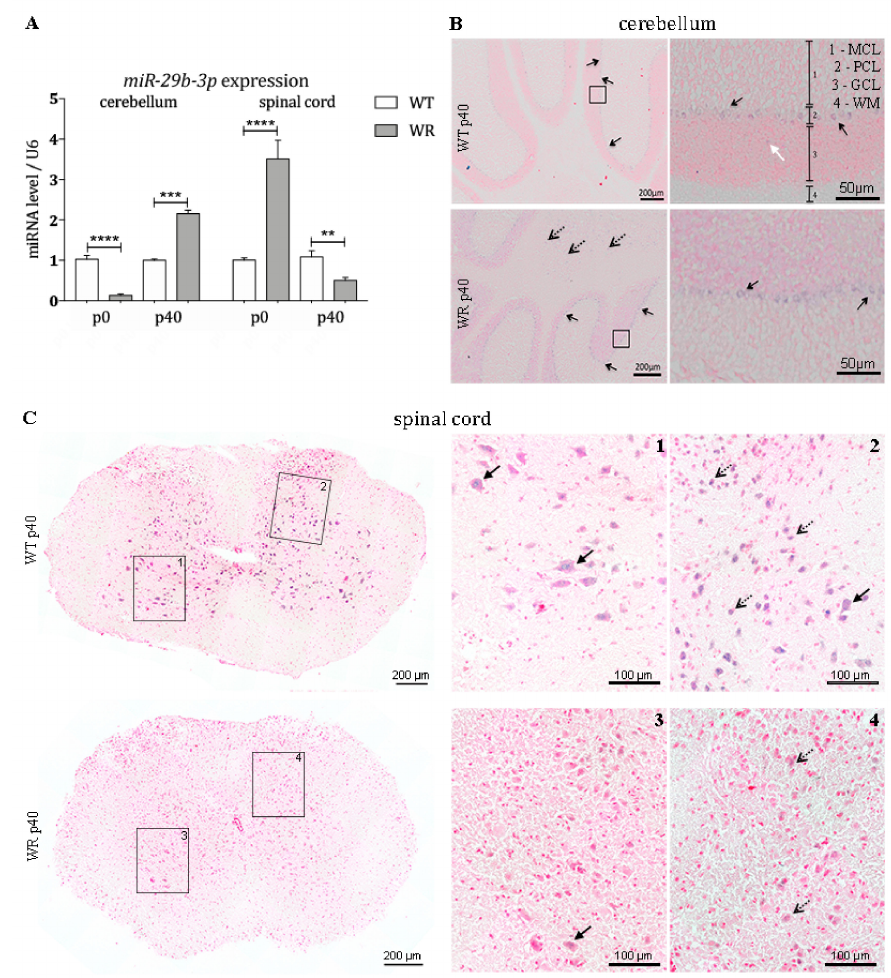
Figure 4. Age-dependent di ff erential expression of miR-29b-3p in cerebellum and spinal cord of wildtype and wobbler mice. ( A ). Expression levels of miR-29b-3p from presymptomatic to stable symptomatic phase of wildtype (WT) and wobbler (WR) cerebella and spinal cords were investigated by qPCR. Significant deregulation of miR-29b-3p was detected at all developmental stages. For relative quantification of miR-29b-3p expression, the 2 − ∆∆ Ct method was conducted using the housekeeping gene U6 for normalization. Data are provided as means ± SEM. Data were tested for significance using Student’s t-test. Significant di ff erences are indicated by ** p < 0.01, *** p < 0.001, **** p < 0.0001; n = 6. ( B ). Exemplary overview of in situ hybridization with miR-29b-3p -probe in a sagittal section of the cerebellum of wildtype (WT) and wobbler (WR) mice at the developmental stage p40. Distinct signals can be found in large cells within the Purkinje cell layer (PCL), indicating Purkinje cells (arrows with closed head). Scattered signals can be found in the granular cell layer (white arrow). In sections of wobbler mice, additional signals can be found in small cells within the white matter (WM) of the cerebellum (arrows with open head). Size of scale bars are indicated in pictures. ( C ). Exemplary overview of in situ hybridization with miR-29b-3p -probe in a cross section of the cervical spinal cord of wildtype (WT) and wobbler (WR) mice at the developmental stage p40. miR-29b-3p staining is mainly apparent within the grey matter of the spinal cord of wildtype mice. Cells with a large cell body, which point to motor neurons (arrows with closed head), express miR-29b-3p . Additional signals can be found in small cells especially in the dorsal horn of the spinal cord (arrows with open head). Wobbler mice show a strongly reduced staining of miR-29b-3p in grey matter. Size of scale bars are indicated in pictures. All pictures were taken with a light microscope (Olympus microscope BX61VS, Japan) and a 20 × objective (UPlanSApo 20 × / 0.4, Olympus, Japan). For counterstaining, Nuclear Fast Red was